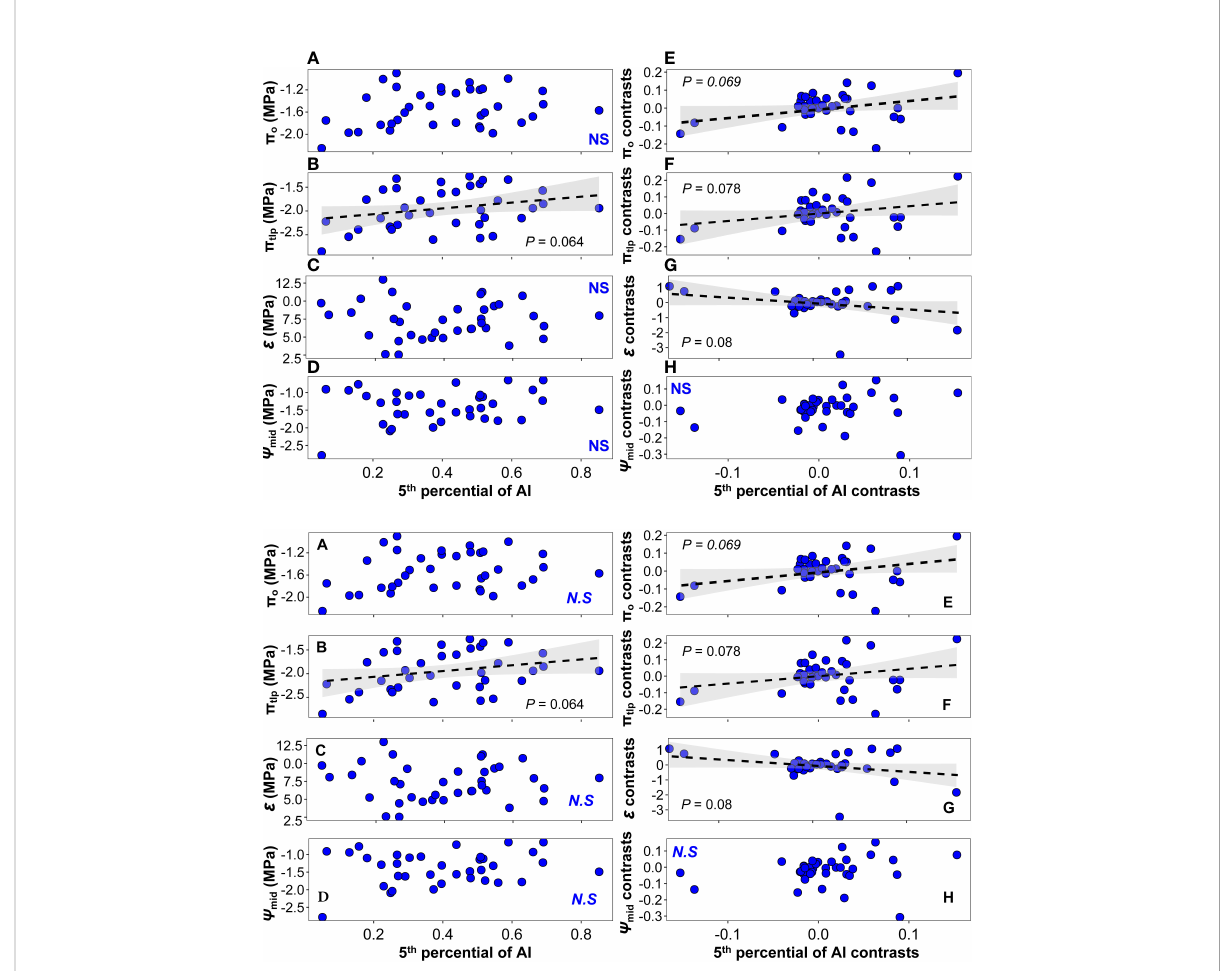
FIGURE 7 Relationships between physiological traits and the 5th percentile of AI at the species level: (A – D) linear regression between physiological traits and the 5th percentile of AI; (E – H) PIC linear regression between physiological traits and the 5th percentile of AI. Black dashed lines indicate marginally signi fi cant linear trends of the 5th percentile of the AI changes of physiological traits, and shallow gray bands represent 95% con fi dence intervals. N.S., non-signi fi cant